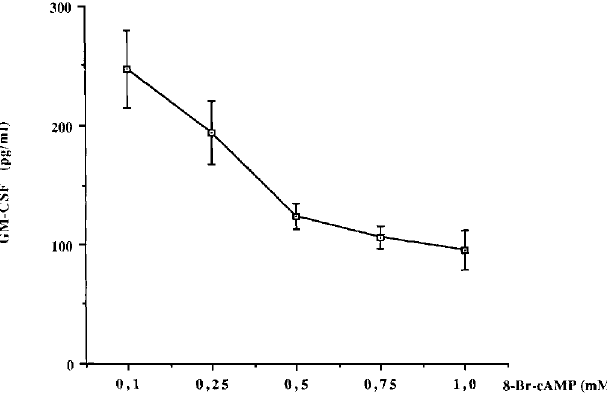
FIG. 3. Dose-dependents of the inhibitory effect of 8BrcAMP on the synthesis of GM-CSF in stromal cells. Confluent secondary stromal cultures were incubated for 24h in medium containing IL-1 (100U/ml) with increasing concen- trations of 8BrCAMP ranging from 0.1 to 1mM. The GM-CSF concentration in the supernatants was assessed using a specific ELISA. Experiments were carried out in triplicate, and data from three independent experiments are summa- rized as mean ±